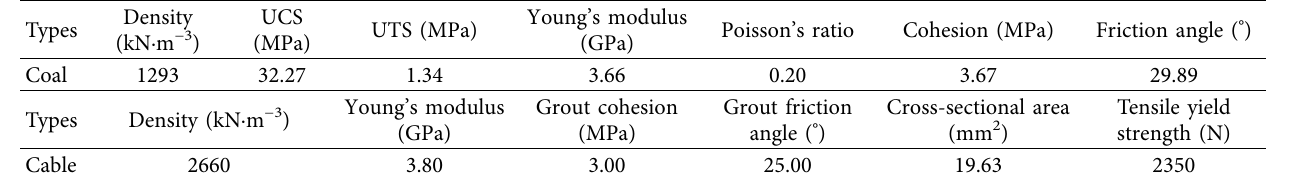
Figure 2: Geometric model of borehole pressure Table 1: Numerical model mechanical parameters.